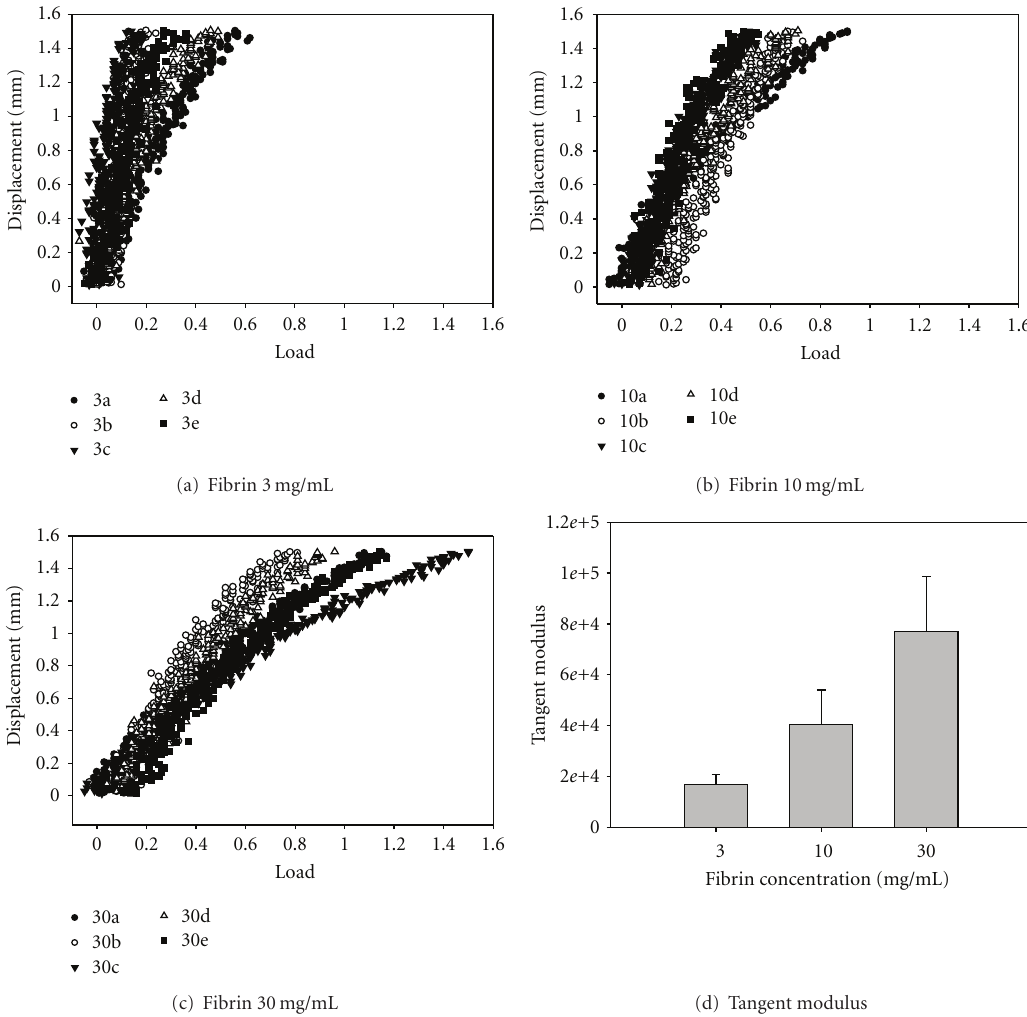
Figure 5: Tangent modulus of a range of fibrin gel produced with varying fibrinogen concentrations. Fibrin gels were made by mixing fibrinogen (3, 10, and 30mg/mL) with thrombin (1 μ l/mL). Tensile testing of the gels was performed using a Bose ElectroForce 3200 (a–c). The tangent moduli were calculated from the slope of the plot of stress versus strain at 20% strain ( n = 6)